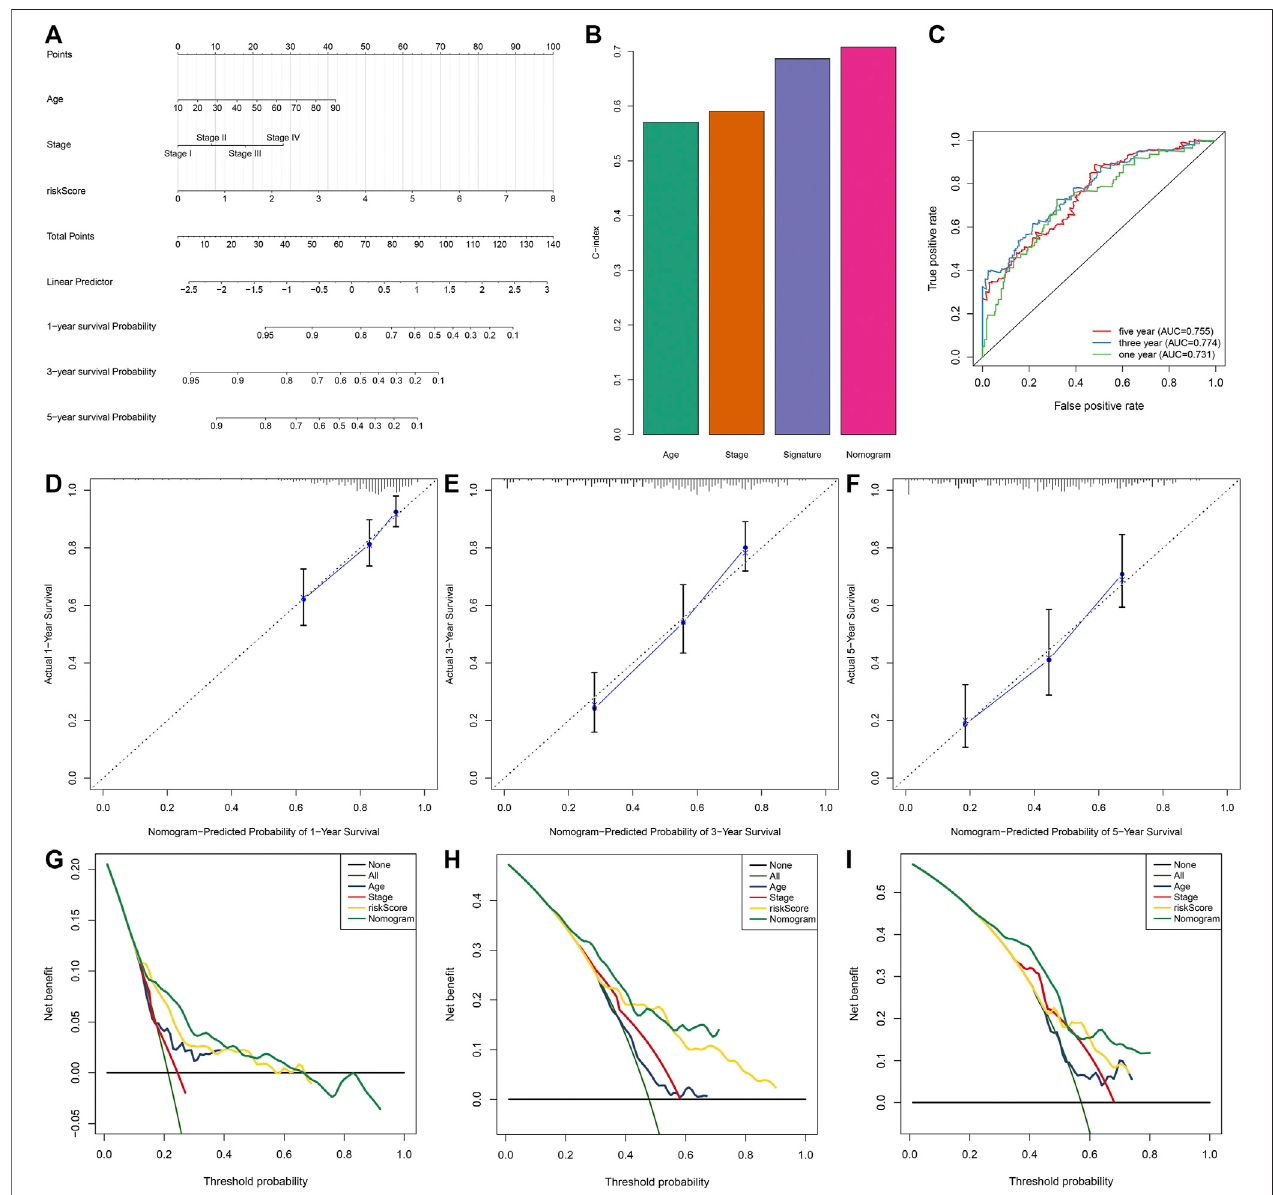
FIGURE4| Development ofaprognostic nomogram forOSCC patients intheTCGA dataset. (A) Thenomogramcovering IRS,stage, andage forprediction of1-, 3-, and 5-yearsurvivalprobabilities. (B) C-index ofage,stage, IRS, and nomogram in predicting OS. (C) ROCcurvesat 1-, 3-, and 5-year OSbased on thisnomogram. (D – F) Calibration curves of this nomogram in prediction of 1-, 3-, and 5-year OS. (G – I) DCA of nomogram, age, stage, and IRS in terms of OS of OSCC patients. X -axis indicated the threshold probability, and Y -axis demonstrated the net bene fi t.